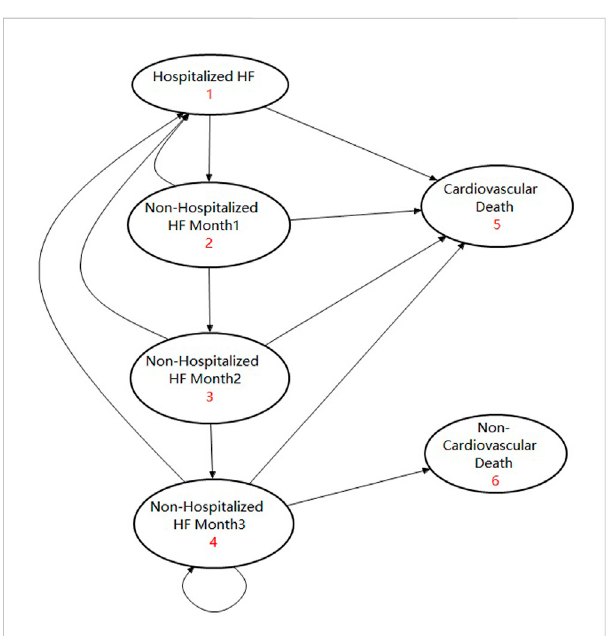
FIGURE 2 Abbreviation: HF, heart failure. Diagram of the Markov model using the state